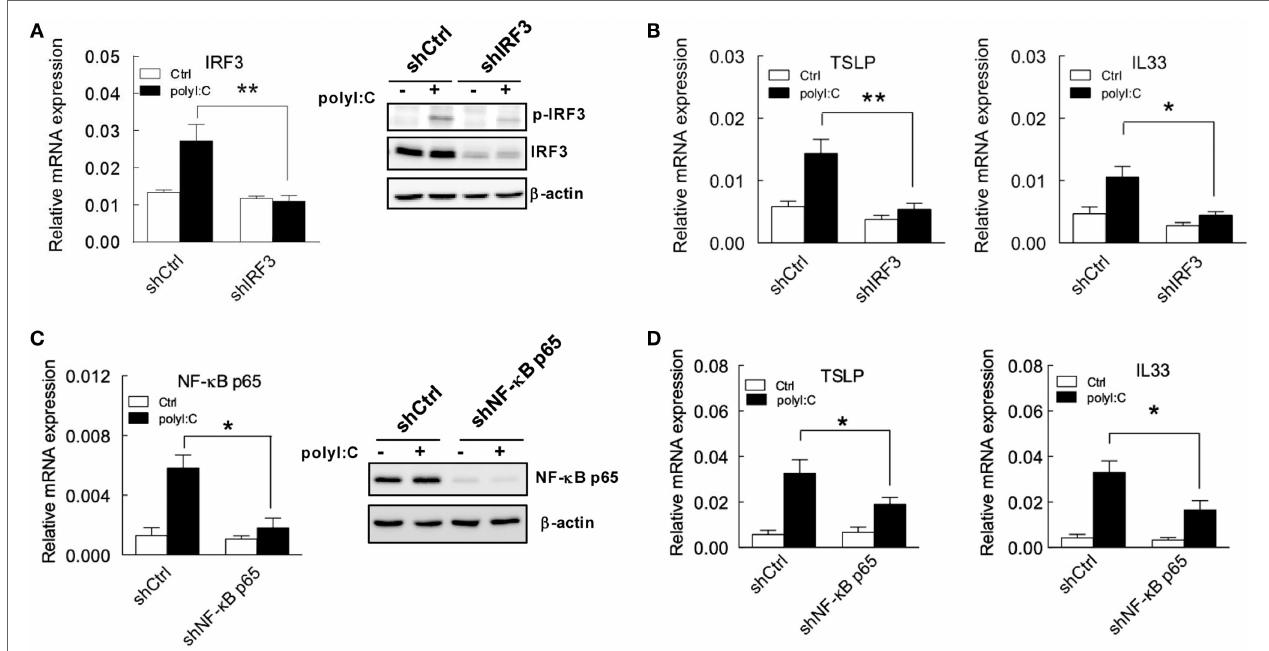
FigUre 4 | TslP and il33 induction is inhibited in h292 cells with irF3 and nF- κ B p65 knockdown with polyi:c stimulation . (a,c) H292 cells were infected with lentivirus carrying IRF3 and NF κ B p65 shRNA. After puromycin selection, the mRNA and protein expression of IRF3 and NF- κ B p65 was analyzed by RT-qPCR (left panel) and immunoblotting (right panel), respectively. Data shown are representative of three different experiments. (B,D) TSLP and IL33 mRNA expression was measured by RT-qPCR in H292 cells with IRF3 and NF- κ B knockdown that were treated with polyI:C. Data are mean ± SD from three independent experiments. * P < 0.05, ** P <